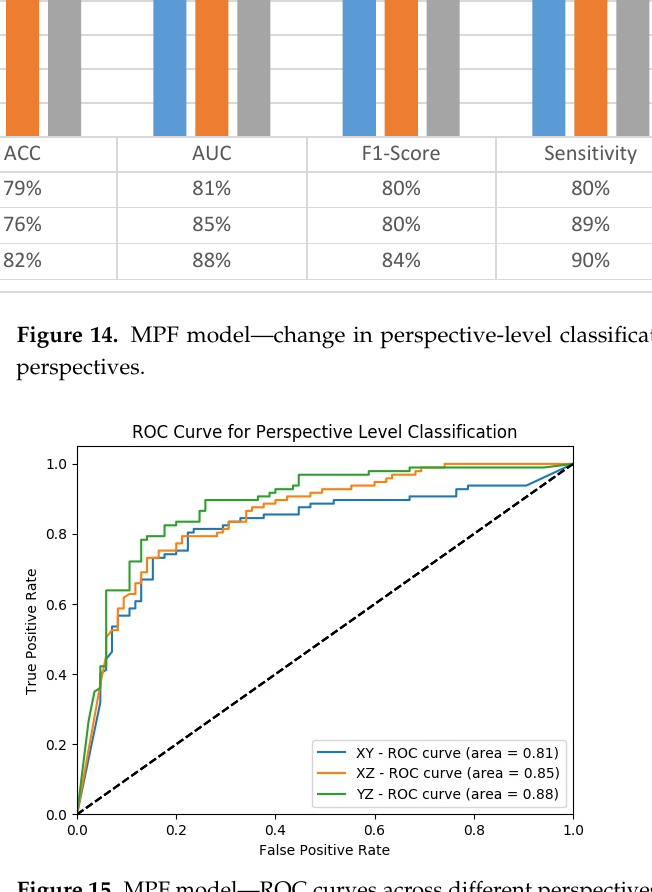
Figure 15. MPF model—ROC curves across different perspectives for perspective level classifica- tion.